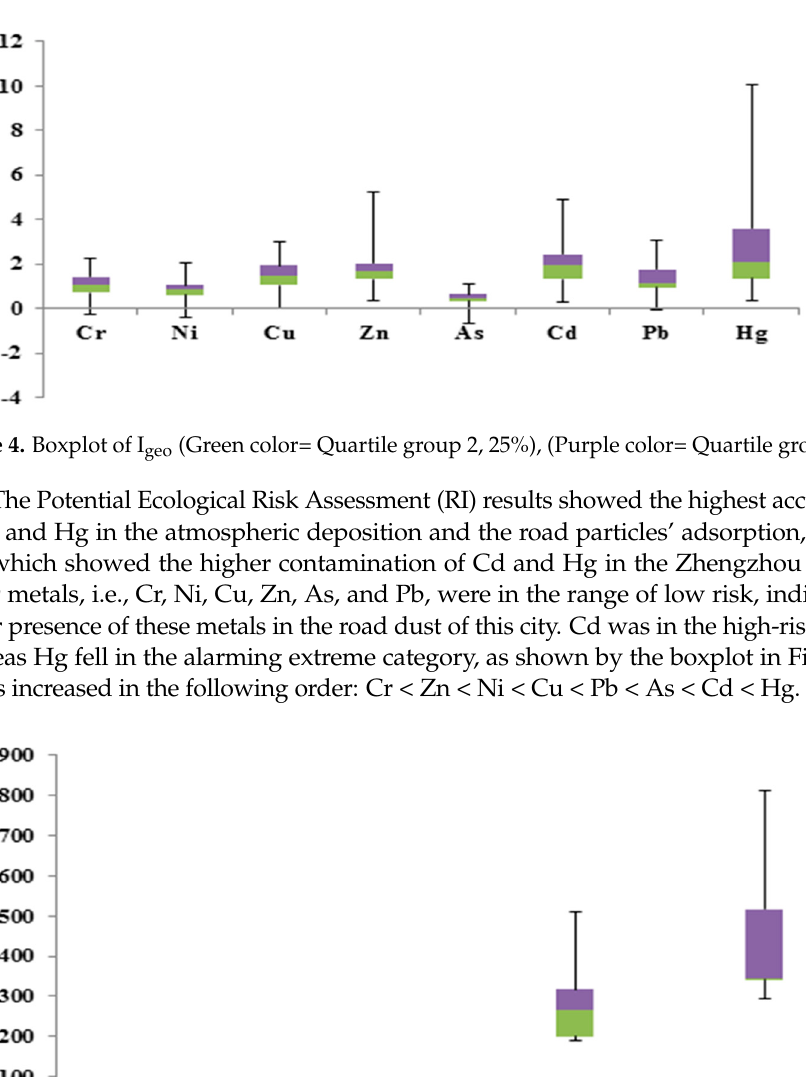
Figure 5. Boxplot of RI (Green color= Quartile group 2, 25%), (Purple color= Quartile group 3, 25%)